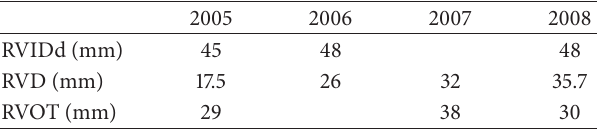
Table 1: Right ventricle size on